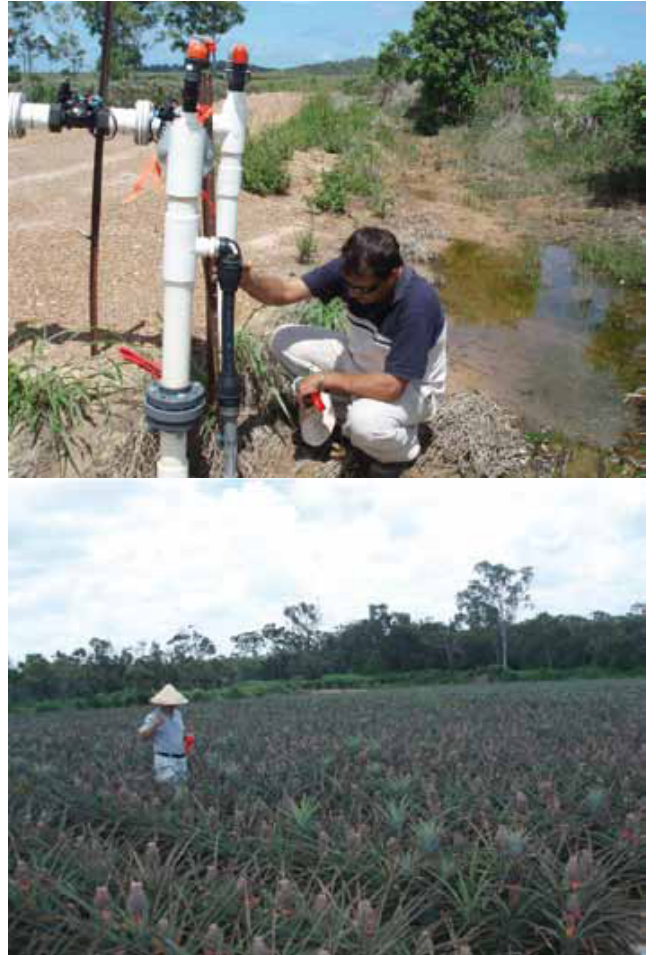
Fig. 2 - Mazzei air injector installed in a pressurised irrigation line close to the plot for air injection into irrigation water for oxygation (top), and the first year crop at fruit development stage (b) being marked for destructive